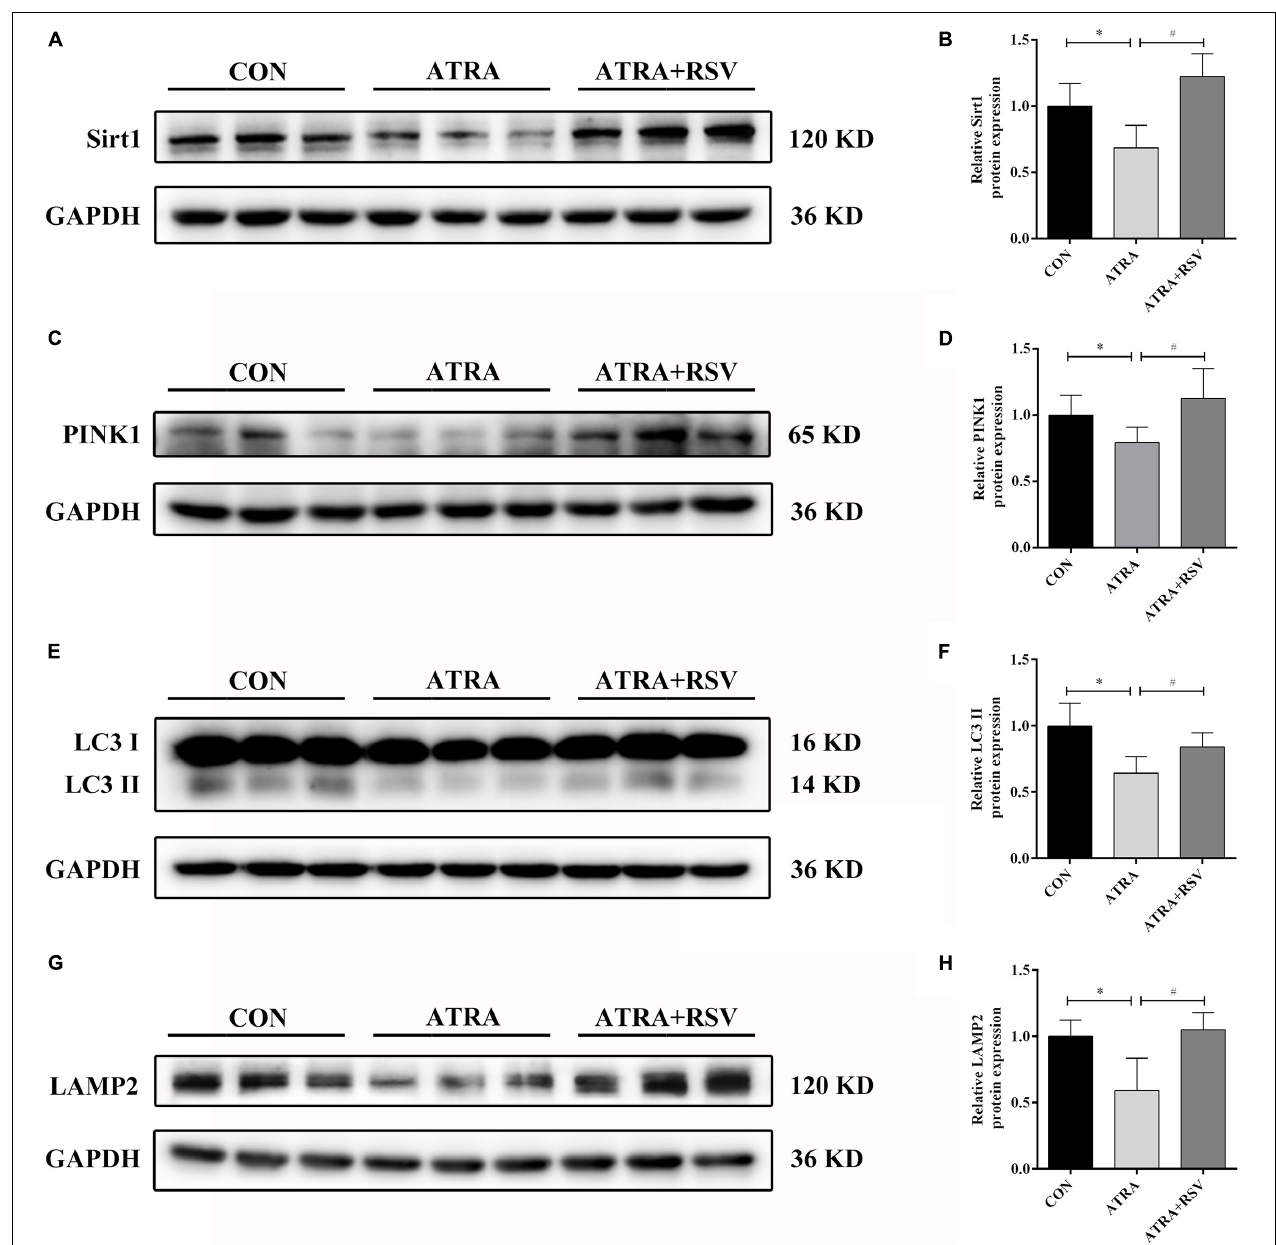
FIGURE 3 | RSV activates Sirt1 and ameliorates autophagy suppression in rat embryos with ATRA-induced SBA. (A) Western blot of Sirt1 protein expression in rat embryonic spinal cord tissues in the CON, ATRA, and ATRA + RSV groups. (B) Quantitation of Sirt1 protein ( n = 6). (C) Western blot of PINK1 protein expression in rat embryonic spinal cord tissues in the CON, ATRA, and ATRA + RSV groups. (D) Quantitation of PINK1 protein ( n = 6). (E) Western blot of LC3 protein expression in rat embryonic spinal cord tissues in the CON, ATRA, and ATRA + RSV groups. (F) Quantitation of LC3 II protein ( n = 6). (G) Western blot of LAMP2 protein in rat embryonic spinal cord tissues in the CON, ATRA, and ATRA + RSV groups. (H) Quantitation of LAMP2 protein ( n = 6). The CON group tissues were taken from normal embryos, ATRA group and ATRA + SRV group tissues were taken from embryos with SBA phenotypes. Results are expressed as the mean ± SD. ∗ p < 0.05 vs. CON group; # p < 0.05 vs. ATRA